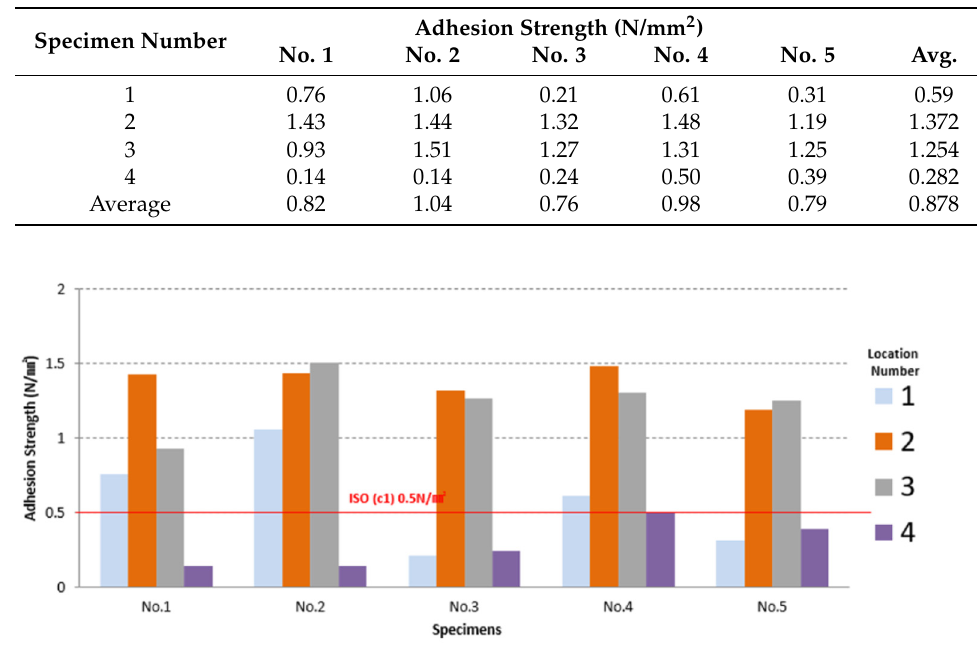
Figure 7. ISO standard adhesion strength evaluation results.